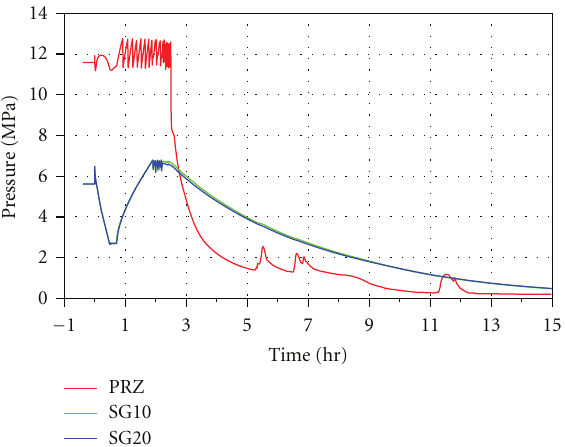
Figure 17: Flow rate through pressurizer relief tank—water and